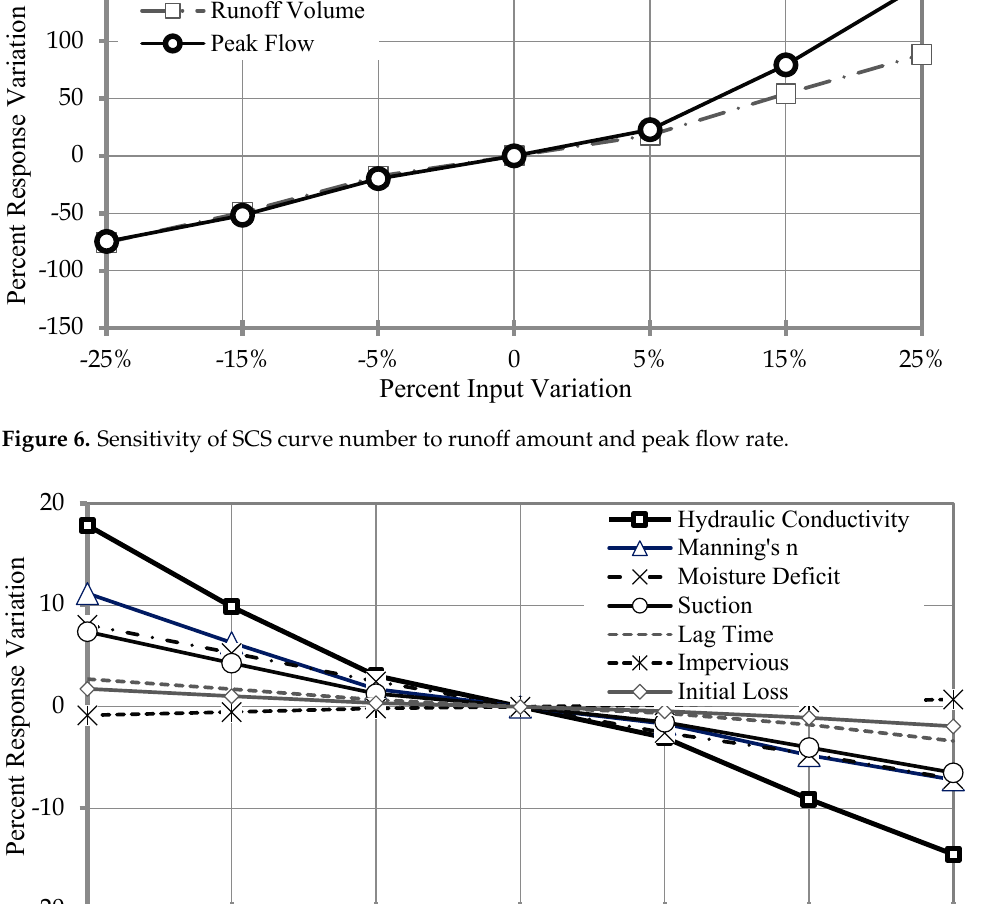
Figure 8. Sensitivity of peak flow rate to several input parameters for Green and Ampt method. Based on the literature and HEC-HMS technical manual guide (USACE, 2000), the following input parameters were identified for the sensitivity test: initial abstraction and curve number (SCS Loss Method), lag time (SCS Unit Hydrograph), moisture deficit, hy- draulic conductivity, impervious percent, suction at wetting front (Green and Ampt loss), and Manning’s roughness coefficient (Muskingum–Cunge routing). These parameters varied in their range of probable values, and thus, the absolute effects of different input parameters were compared. The mode outputs—i.e., runoff amount and peak flow—were selected as the objective functions for the comparison purposes. The SCS curve number (CN) method [54] is a widely used empirical parameter ap- proach, used in this study to determine the approximate amount of direct runoff from a rainfall event. The runoff curve numbers are based on the hydrologic soil group, land use treatment, and hydrologic condition of the area. The estimation procedure is discussed in detail in the National Engineering Hydrology—NEH-4 handbook [54]. The SCS Unit Hy- drograph method was selected to simulate the surface runoff hydrographs. It is based on the dimensionless unit hydrograph approach, developed by Victor Mockus in the 1950s, and is described in detail in the SCS Technical Report [54–56].